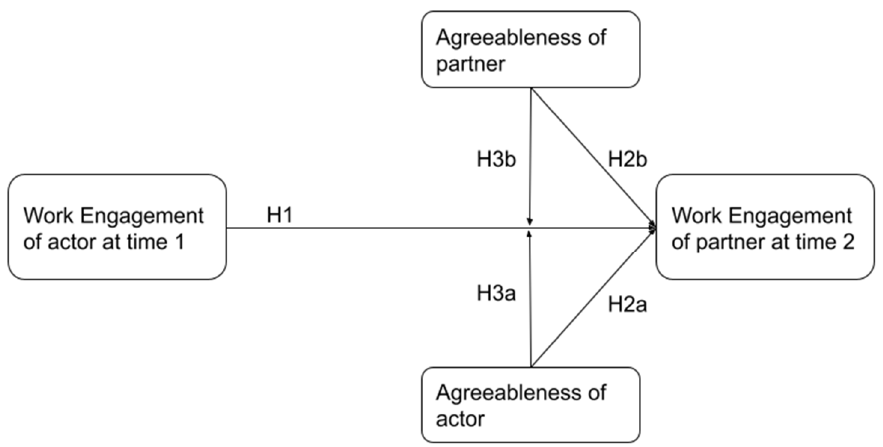
Figure 1. Hypothesized crossover model of work engagement.